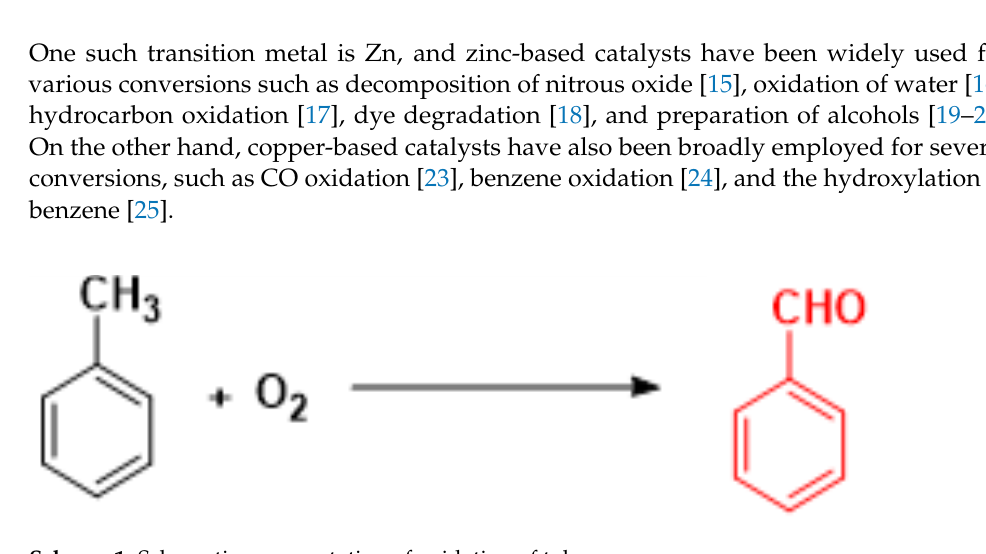
Scheme 1. Schematic representation of oxidation of toluene.